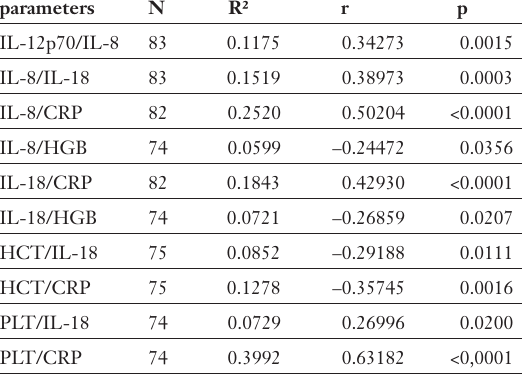
Correlation analysis in patients with ulcerative colitis (CAI: Clinical Activity Index, CRP: C-reac- tive protein, HGB: haemoglobin, WBC: white blood cells, HCT: haematocrit, PLT: